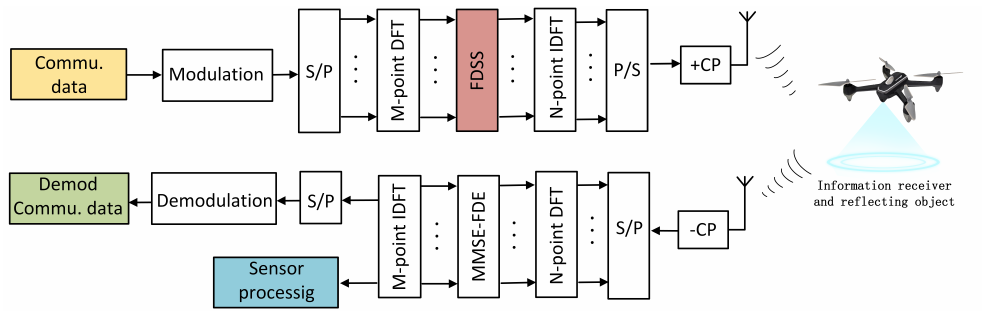
Figure 7. ISAC system structure based on FDSS-enhanced